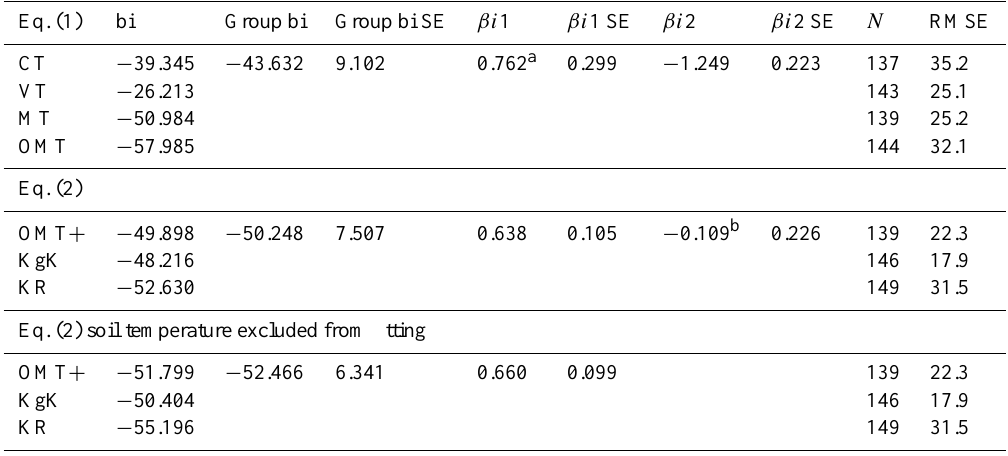
Table 2. Parameter estimates and their standard errors for trend coefficients of CH 4 fluxes (µgm − 2 h − 1 ) of the upland forest types (CT, VT, MT, and OMT, Eq. 1), and for the forest–mire transitions (OMT + , KgK, and KR, Eq. 2). Both equations are functions of volumetric soil moisture at 10cm (%) and soil temperature at a depth of 5cm ( ◦ C). Eq. (1)